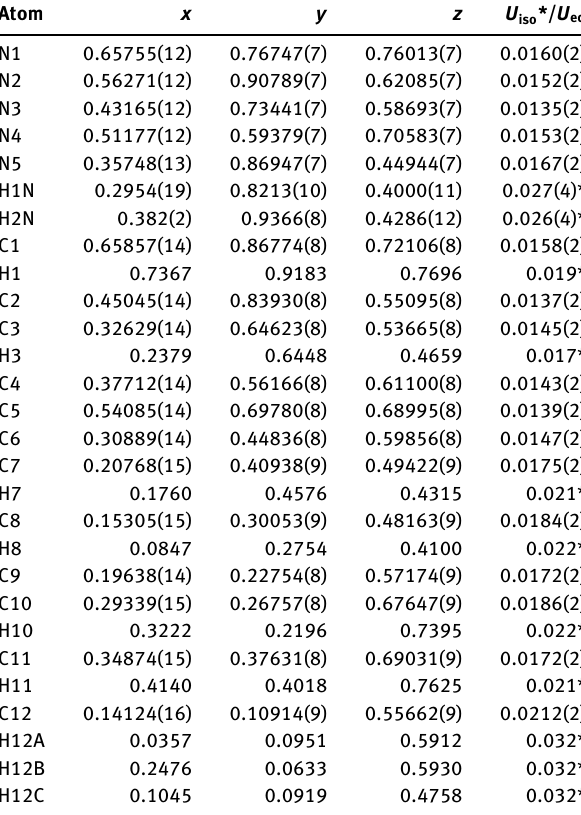
Table 2: Fractional atomic coordinates and isotropic or equivalent isotropic displacement parameters (Å 2